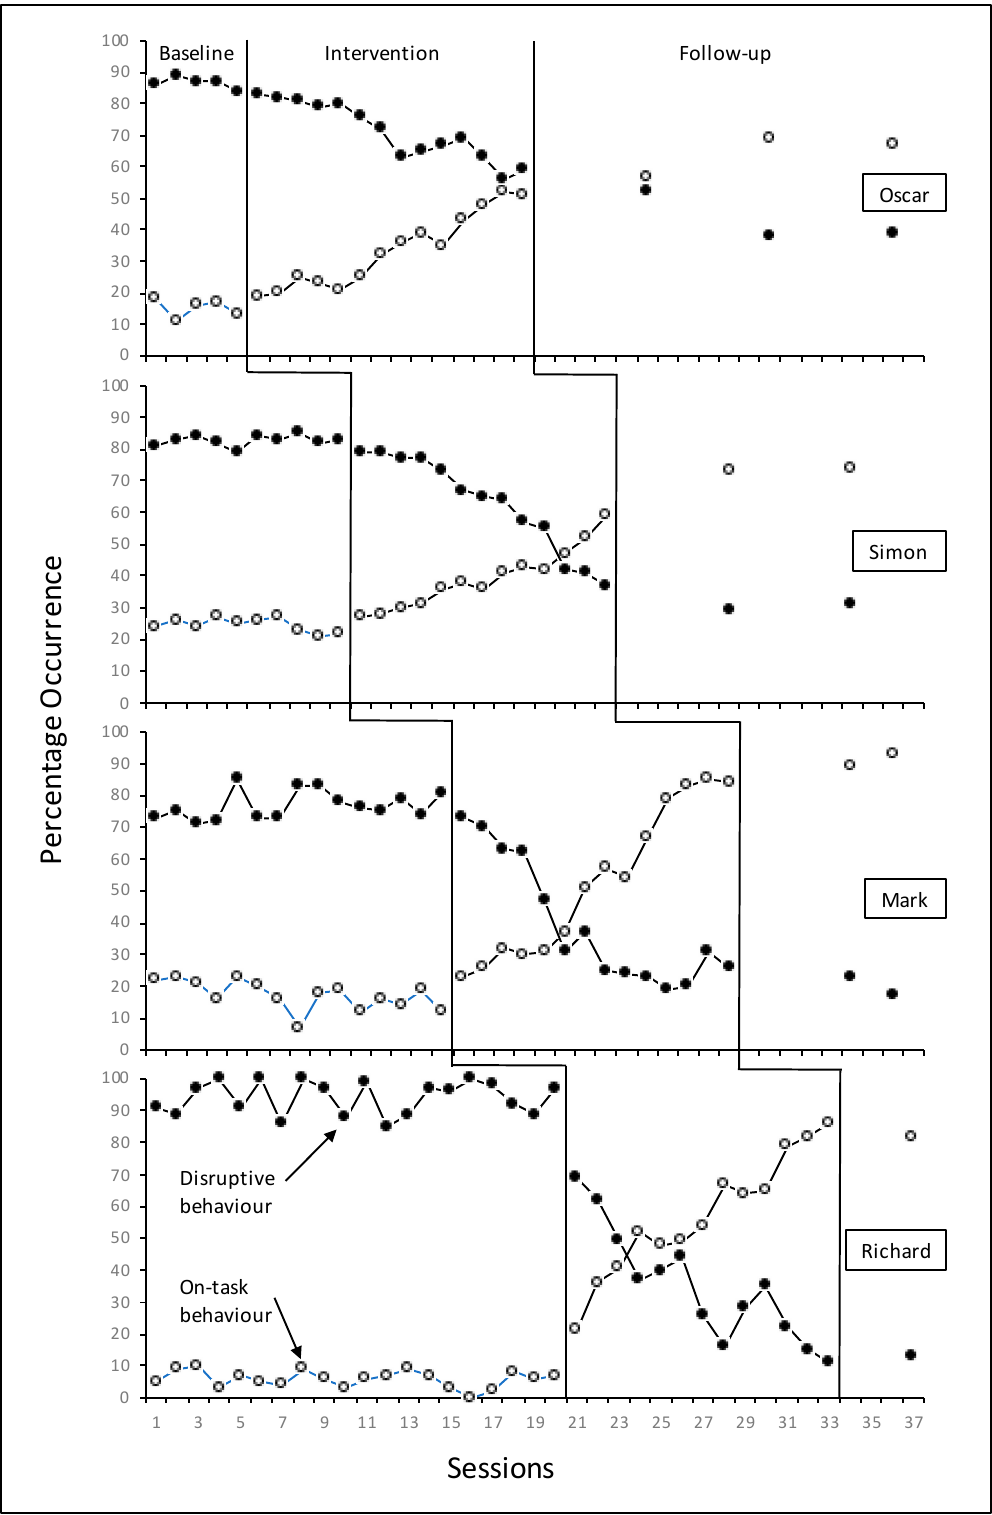
Figure 1. Percentage of 10 s intervals of on-task and disruptive classroom behaviours during 20 min classroom observations across all phases.